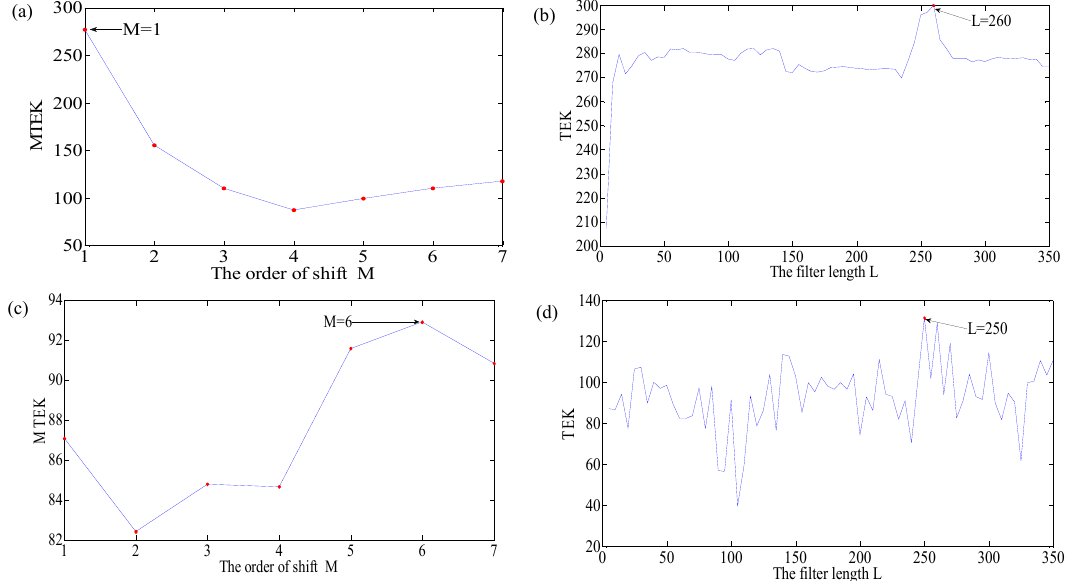
Figure 16. The variation curves of MTEK and TEK for case 2: ( a ) T o = 200, the tendency of MTEK with M; ( b ) T o = 200, the TEK result for outer race; ( c ) T i = 125, the tendency of MTEK with M; ( d ) T i = 125, the TEK result for outer race.